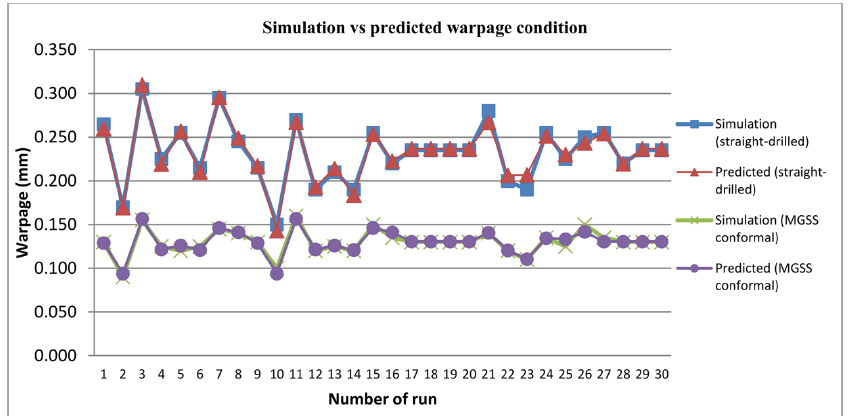
Figure 7. Simulation and predicted results of warpage for both cooling channels.